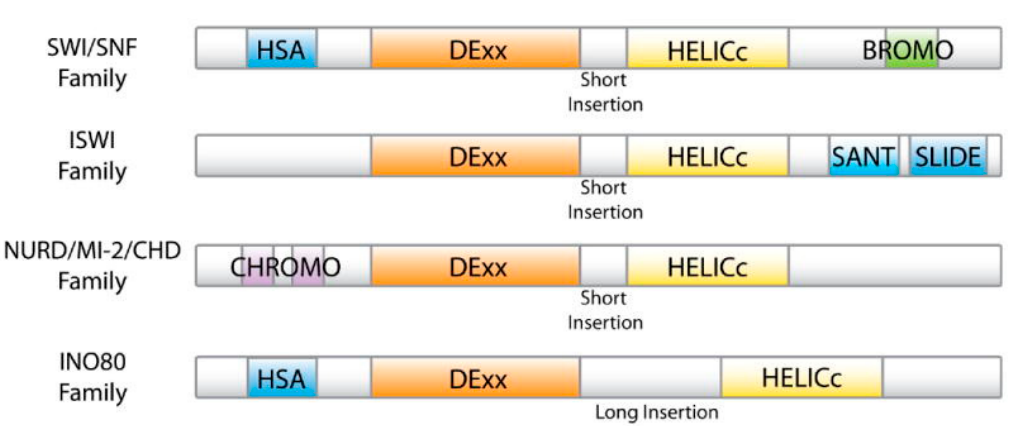
Figure 1. Domain organization of the ATPase subunits found in different ATP-dependent chromatin remodeling complexes [12].